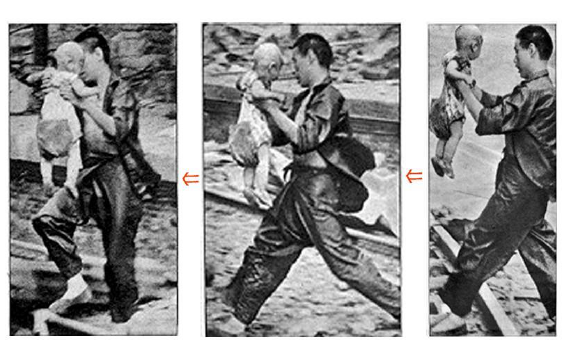
Figure 4. Filmed images of baby Ping-Mei. Source: LOOK Magazine.